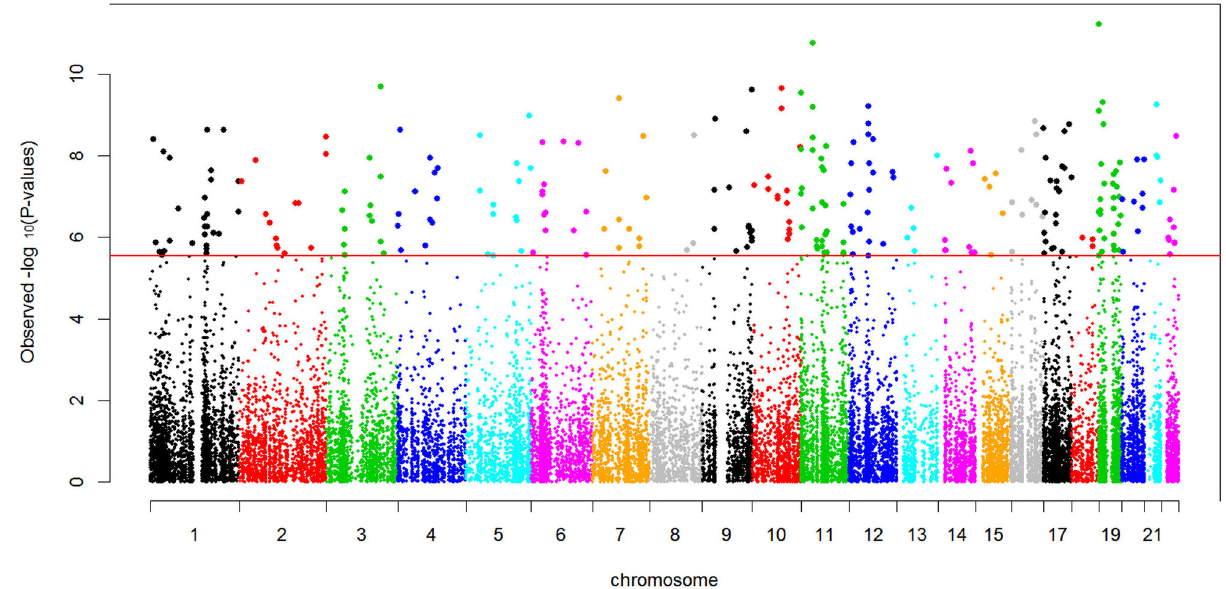
Figure 2. Manhattan plot of methylome-wide association with log CRP in 966 African Americans, adjusted for age, gender, BMI and cigarette smoking. doi: